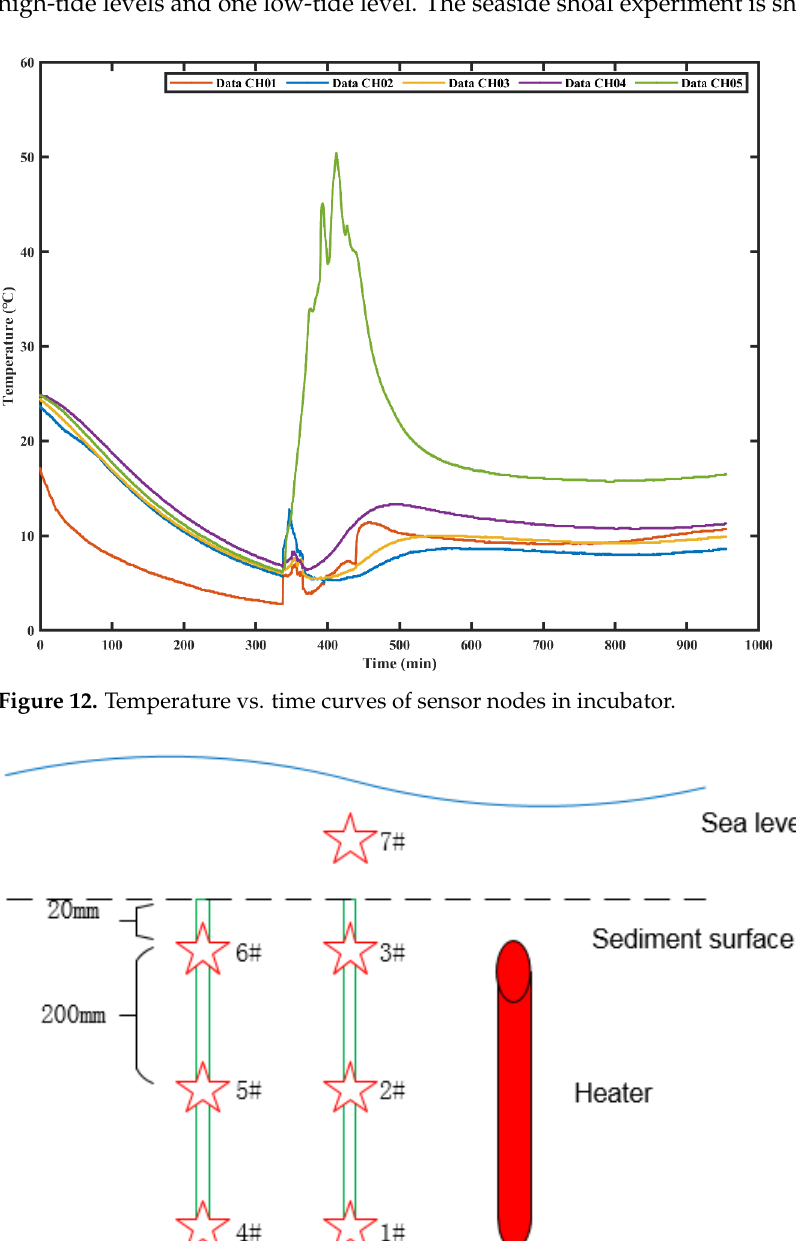
Figure 11. Arrangement of heating source and temperature sensors in the incubator. 1#–5# in the figure represent temperature sensors 1–5.